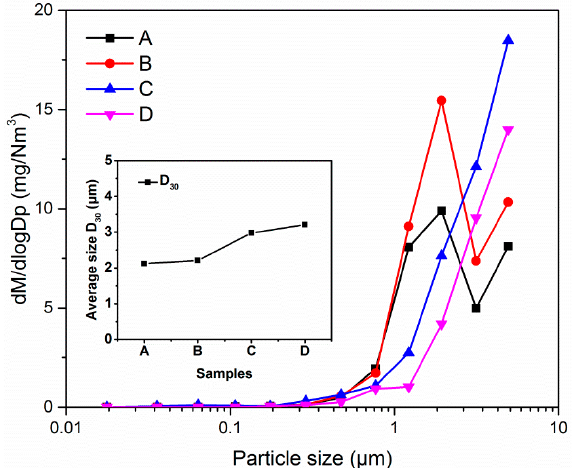
Figure 8. The size distributions of the four particles measured using the reference method.